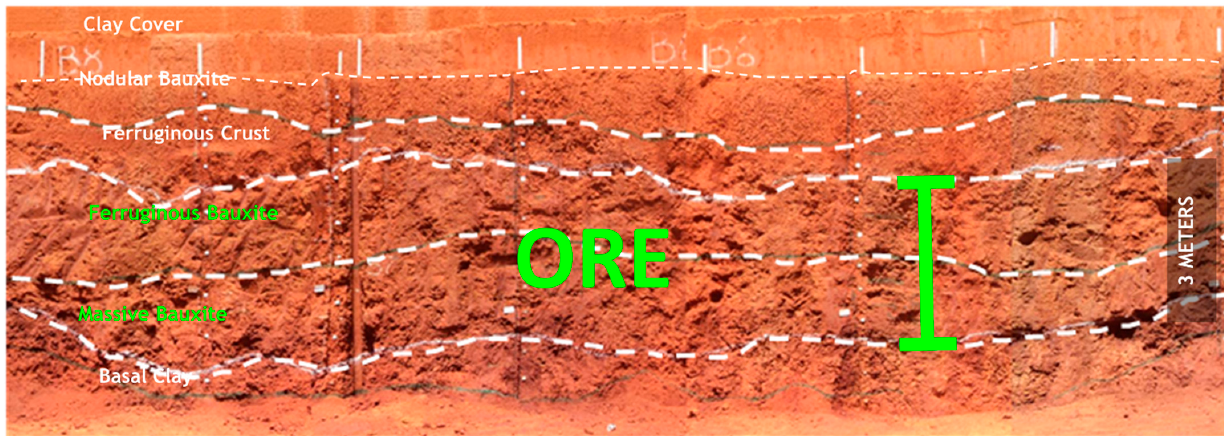
Figure 2. Trench photo showing the lateritic profile in the Rondon do Pará bauxite deposit.